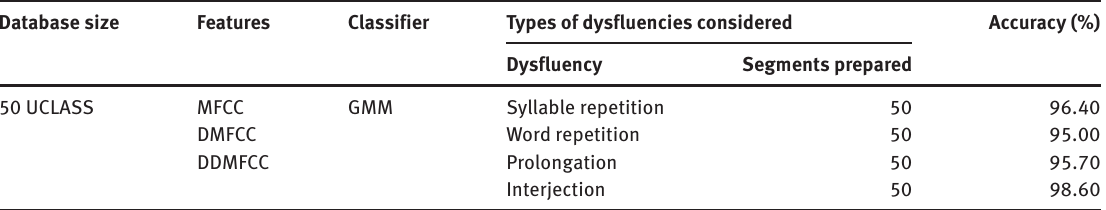
Table 5: Results of Proposed Methods Pertaining to the Recognition of